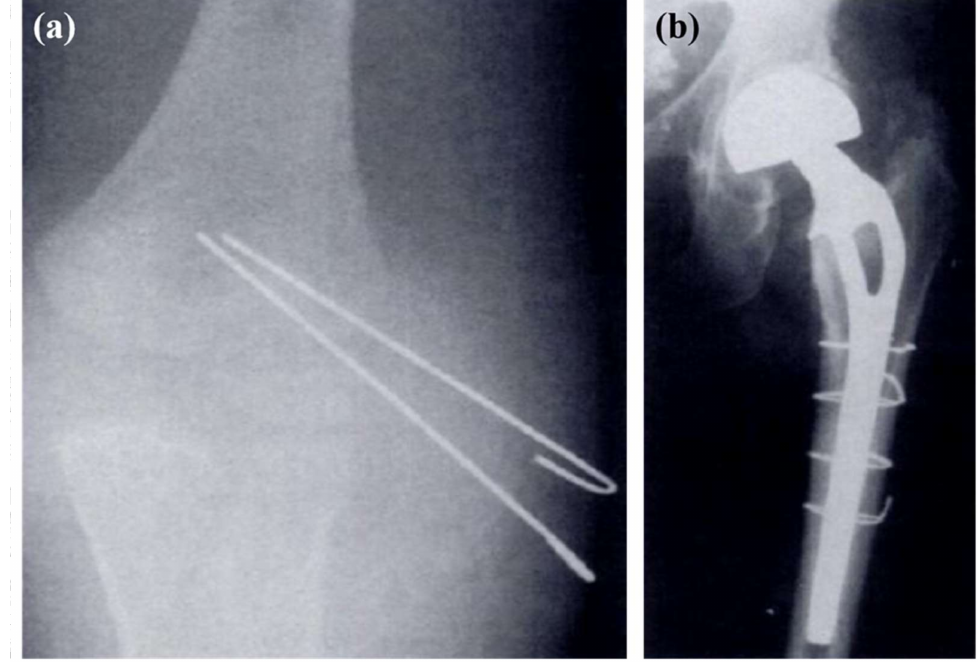
Figure 4. ( a ) Radiographic picture of K-wires used to repair a fracture of the medial epicondyle in the elbow and ( b ) radiograph shows cerclage wiring used to contain bone fragments in a fracture around the stem of a femoral prosthesis, reproduced with permission from [76], The Radiological Society of North America (RSNA ® ),